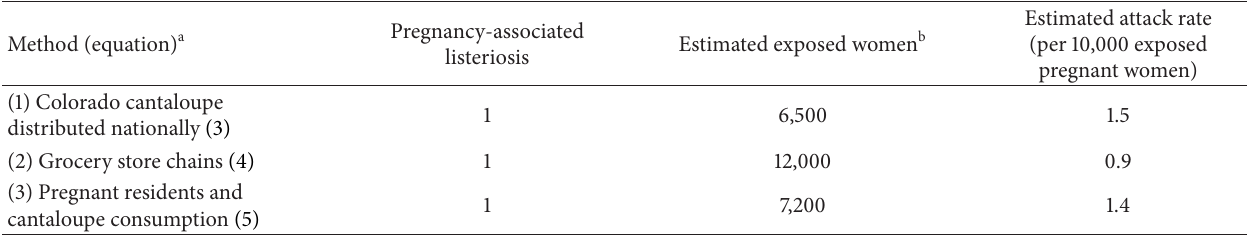
Table 1: Attack rates of listeriosis among pregnant women exposed to contaminated cantaloupe, estimated using three methods, Colorado,